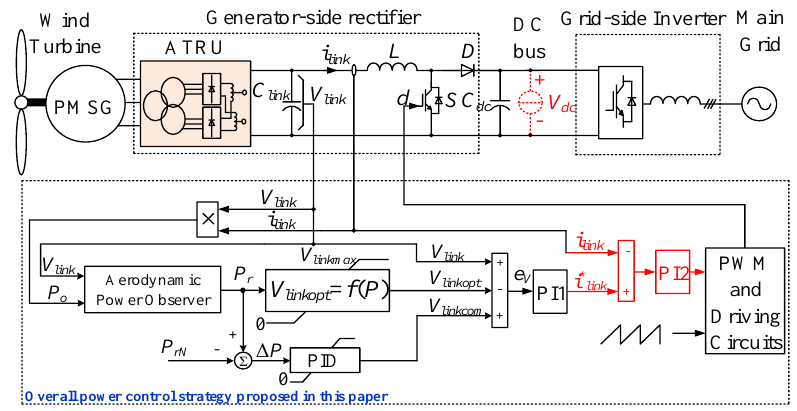
Figure 5. System structure with proposed ATRU and modified overall power controller.